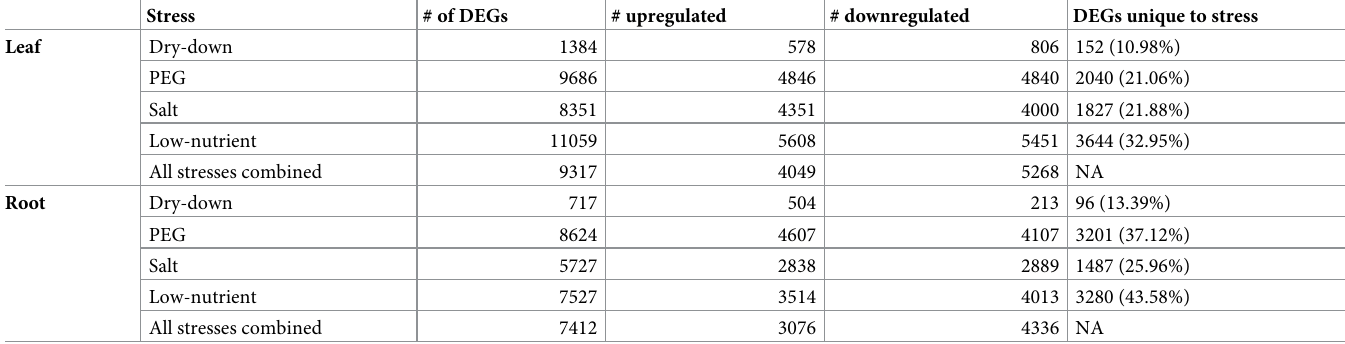
Table 2. The number of DEGs and direction of change as compared to control in each tissue for each stress individually and all stresses combined.